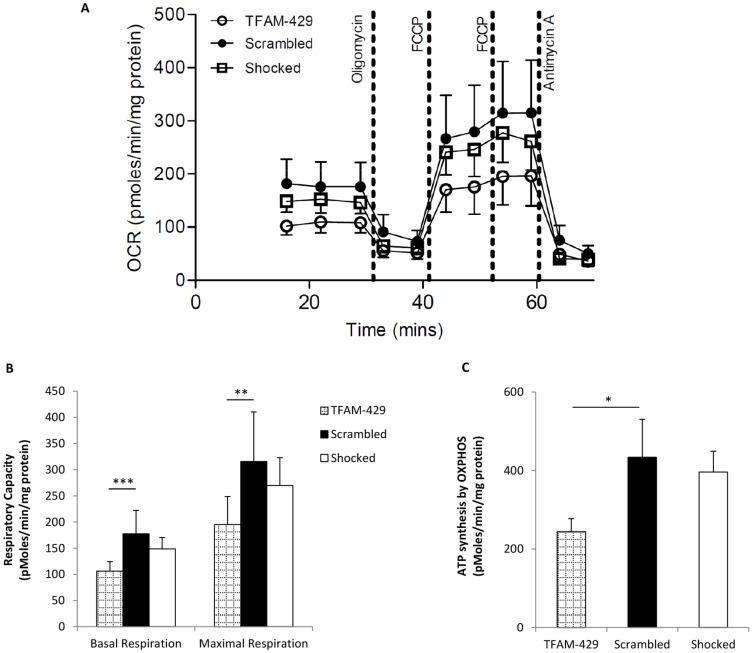
The effect of partial mtDNA depletion on mitochondrial function.Cells were harvested 72 h post transfection and oxygen consumption rate (OCR) was measured using the Seahorse XF24 Analyzer. OCR in TFAM-429 cells (n = 8) was severely impaired compared to that of Scrambled (n = 8) and Shocked (n = 8) control cells (A). Mitochondrial activity was measured following injection of oligomycin, an inhibitor of Complex V (ATP Synthase), followed by two sequential injections of FCCP to uncouple respiration and induce maximal respiration, and finally antimycin, an inhibitor of Complex III (Ubiquinol-Cytochrome c Reductase) preventing electron transfer and subsequently abolishing the proton gradient required for ATP synthesis. Basal and maximal respiratory capacity (B) and ATP synthesis by oxidative phosphorylation (OXPHOS) (C) were calculated as described previously [30]–[32]. Data were normalised to protein concentration and are presented means ± SEM. * p<0.5, ** p<0.001, *** p<0.0001.